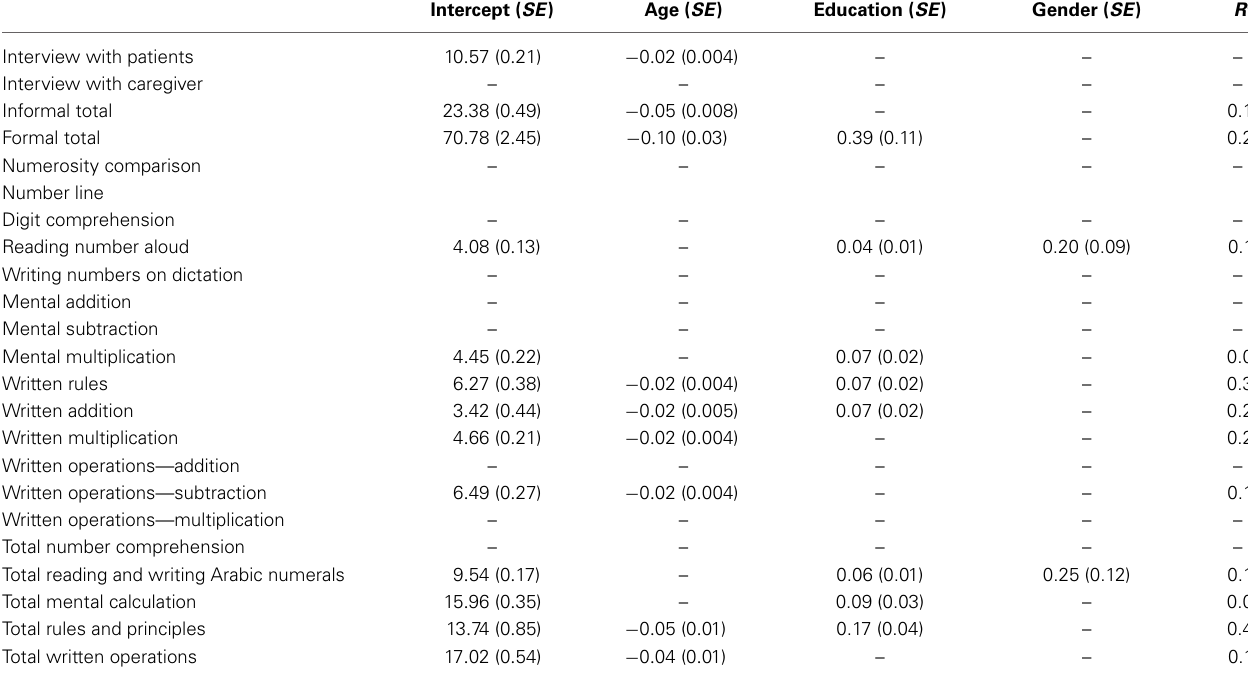
Table 3 | Regression models for cut-off corrections of NADL global scores and scores on